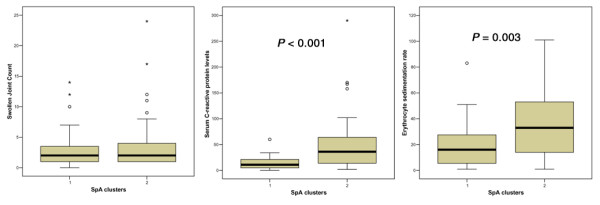
Unsupervised clustering analysis using synovial histopathological parameters identified two main clusters within the spondyloarthropathy (SpA) cohort (n = 82). Whereas there were no differences for the swollen jount count between the two clusters, cluster 2 was characterized by significantly higher serum C-reactive protein concentrations (mg/L) and erythrocyte sedimentation rate (mm/hour). Data are represented as box–whisker plots, with median, 25th to 75th percentile, and 5th to 95th percentile. Comparisons were performed with the Mann–Whitney U test.